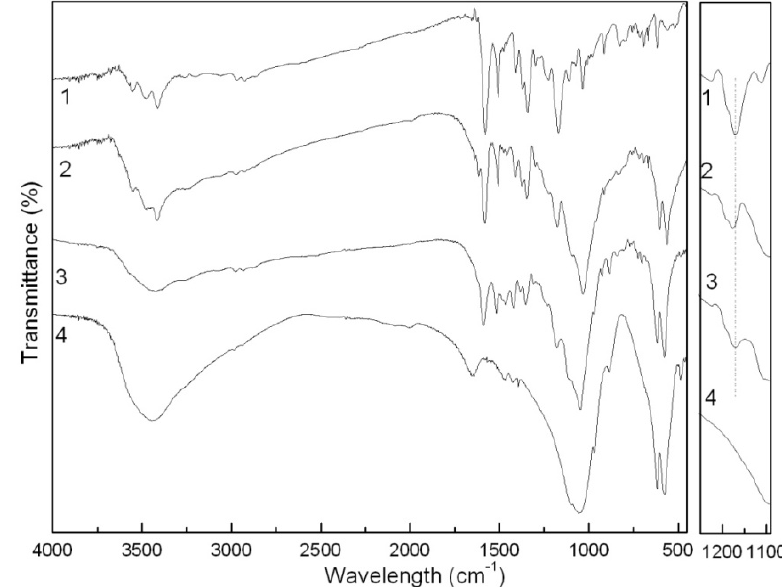
(PO ) -ABB6B hybrid ( 2 ), 3 4 2